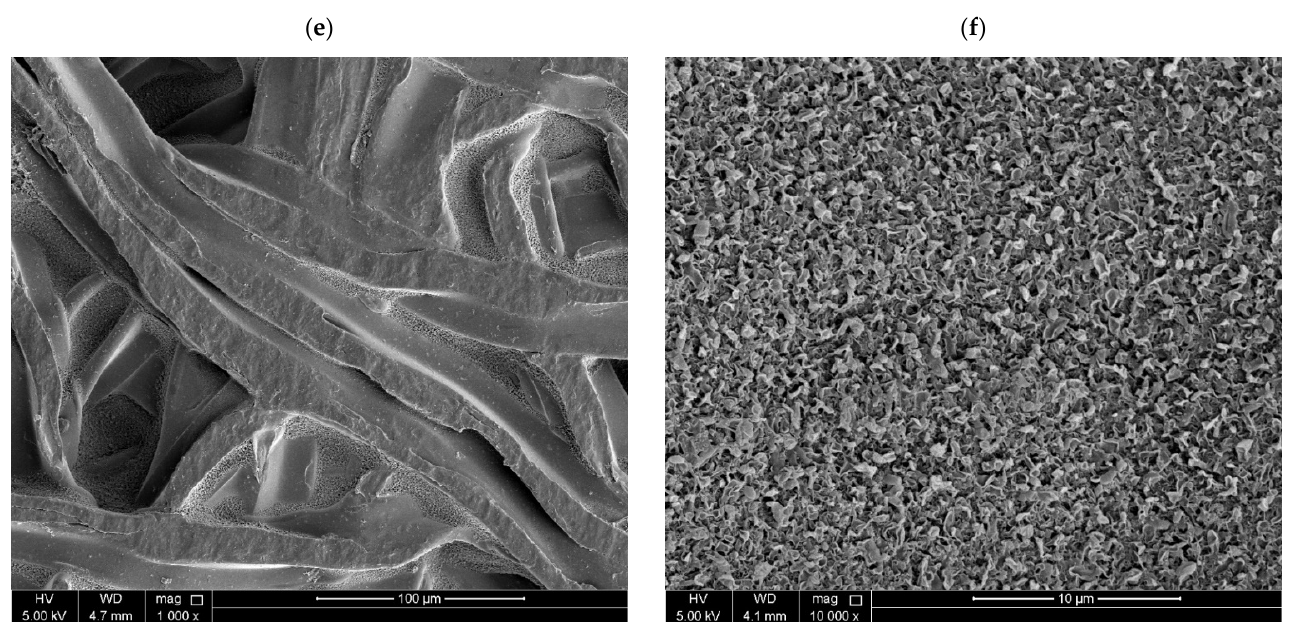
Figure 6. SEM images of ( a ) PES-based NFM substrate layer; ( b ) distribution of nanofiber diameter in NFM substrate; ( c ) topmost surface image of thin-film composite membrane at 1000x magnification; ( d ) topmost surface image of thin-film composite membrane at 25,000x magnification; ( e ) topmost surface image of the 0.05-B-GQD/PA TFNC membrane at 1000x magnification; ( f ) topmost surface image of the 0.05-B-GQD/PA TFNC membrane at 25,000x magnification.